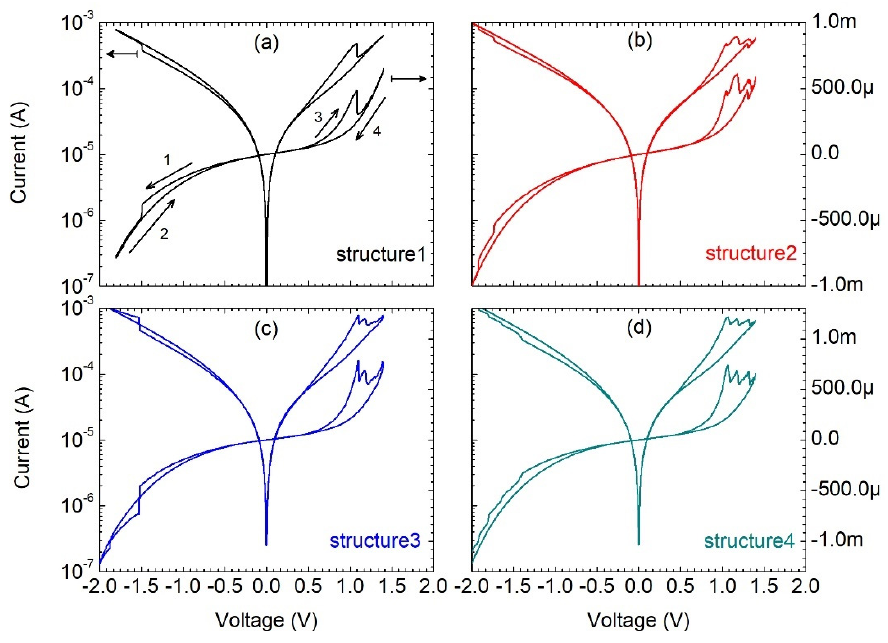
Figure 2. Current–voltage characteristics of Al/SiO 2 /n++ Si structures ( a – d ) with a gate diameter of 156 um.